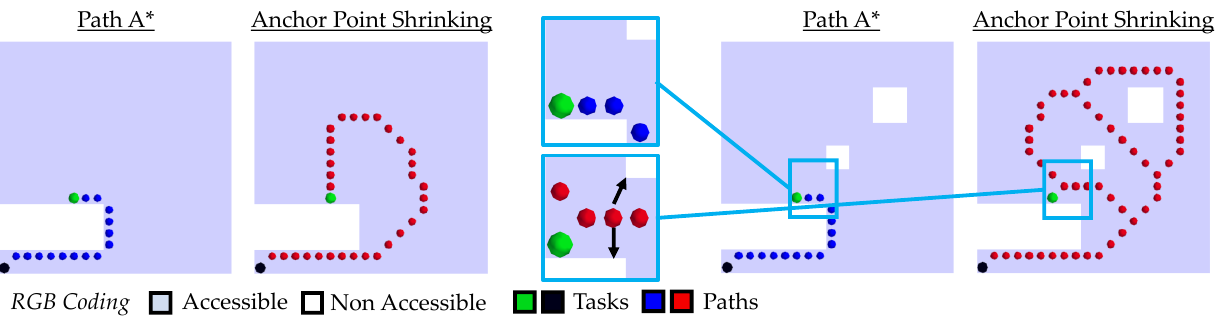
Figure 11. Comparison of applying A* on the image environment and a reduced subset of paths considering anchor point shrinking: first example, second example.